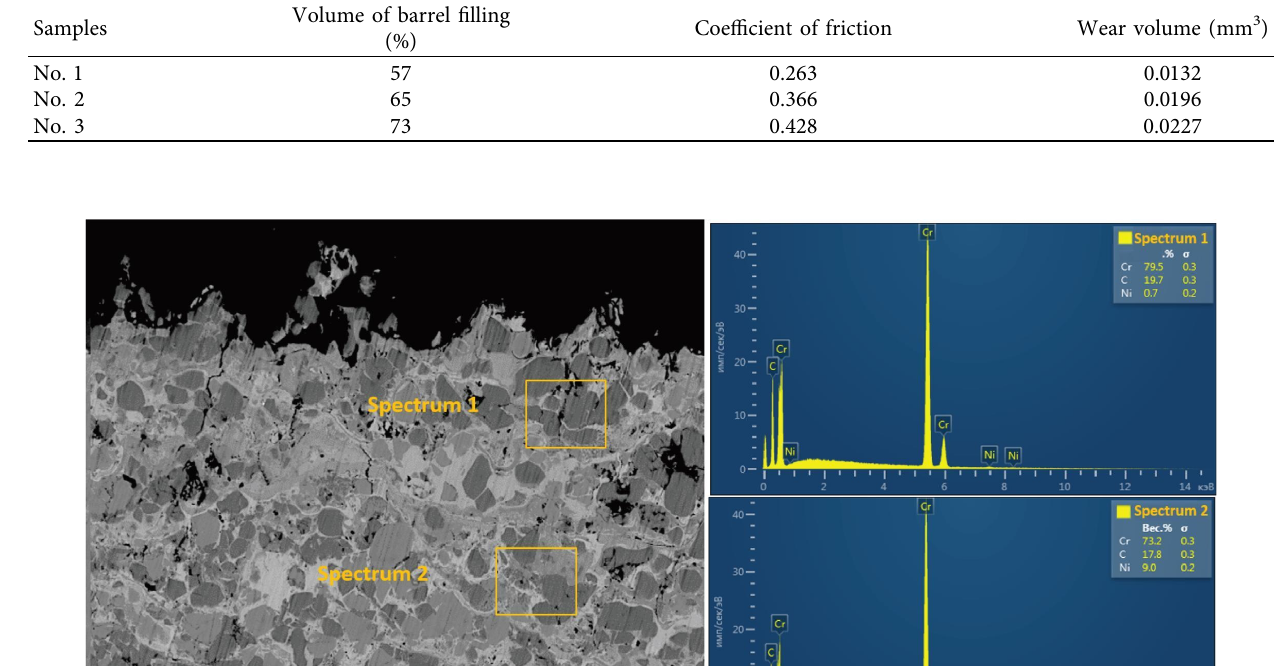
Table 3: Results of the tribological testing of Cr